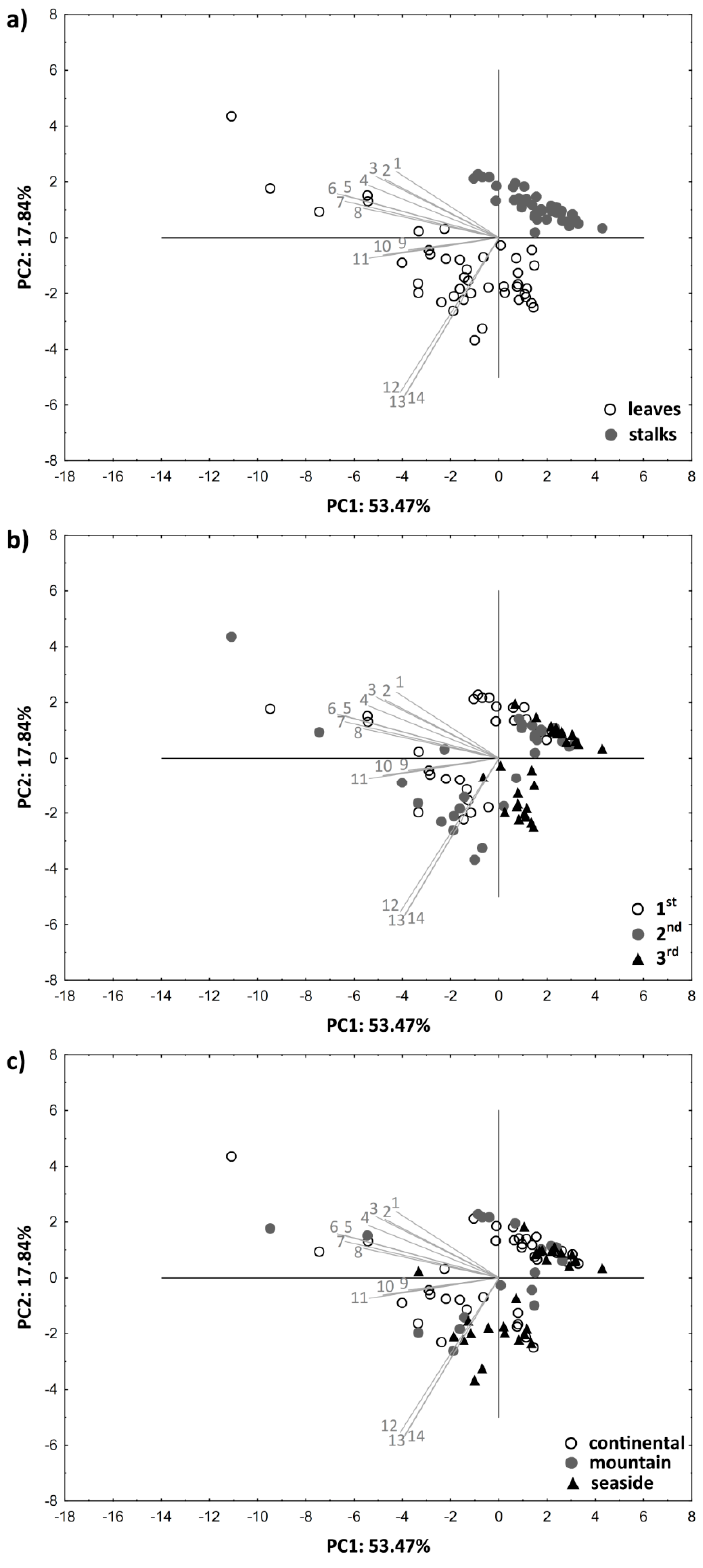
Figure 2. Distribution of wild nettle samples in two-dimensional coordinate system defined by the first two principal components (PC1 and PC2) according to the ( a ) plant part; ( b ) phenological stage; ( c ) growing region (1 = isoflavones, 2 = flavanones, 3 = flavones, 4 = benzoic acids, 5 = cinnamic acids, 6 = total polyphenols, 7 = flavonols, 8 = flavan-3-ols, 9 = other acids, 10 = coumarins, 11 = ORAC, 12 = carotenoids, 13 = chlorophylls, 14 = total pigments).